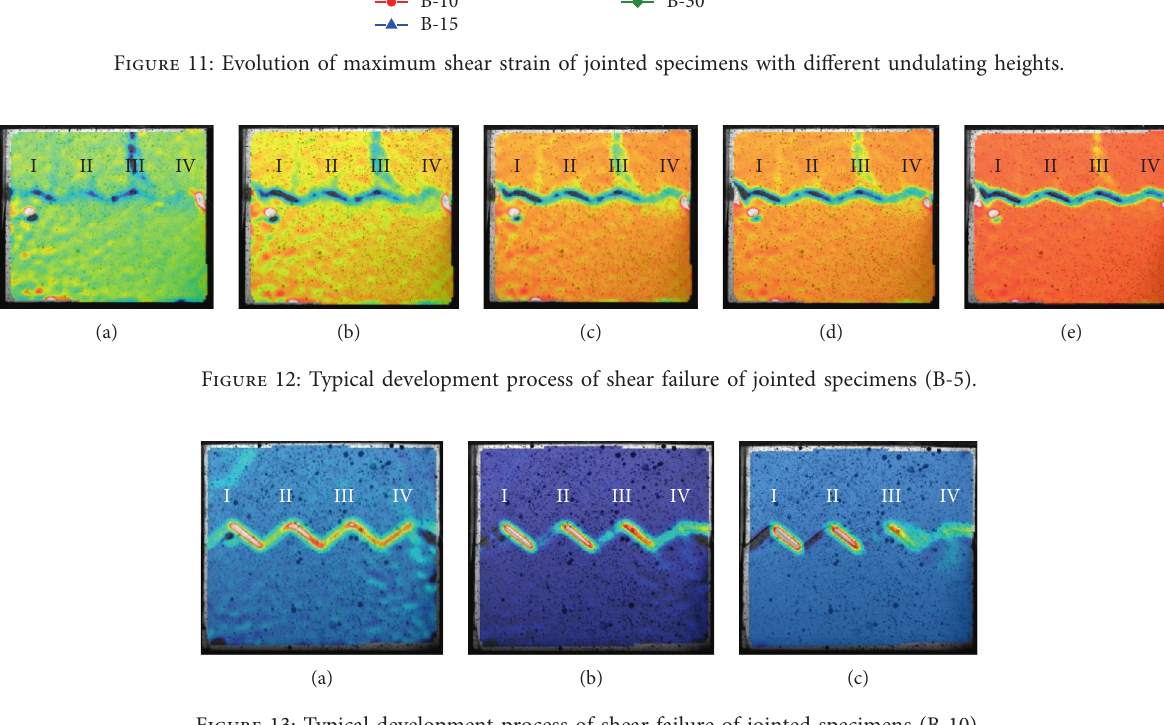
Figure 13: Typical development process of shear failure of jointed specimens (B-10).